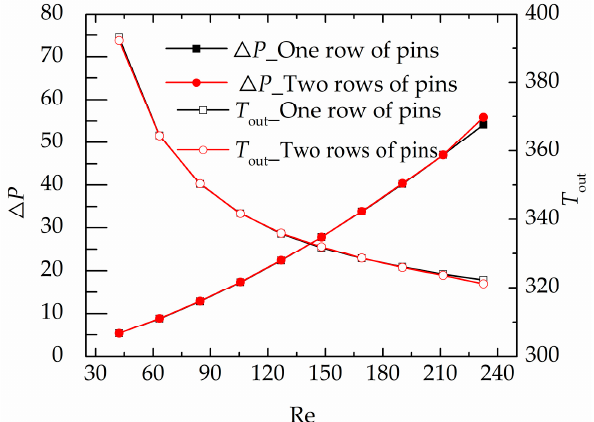
Figure 3. The variation in the pressure drop and outlet temperature of the non-uniform pin-fin array (NPFA) over the Re for the calculation domain with one row of pins and two rows of pins under an inlet temperature of 300 K.